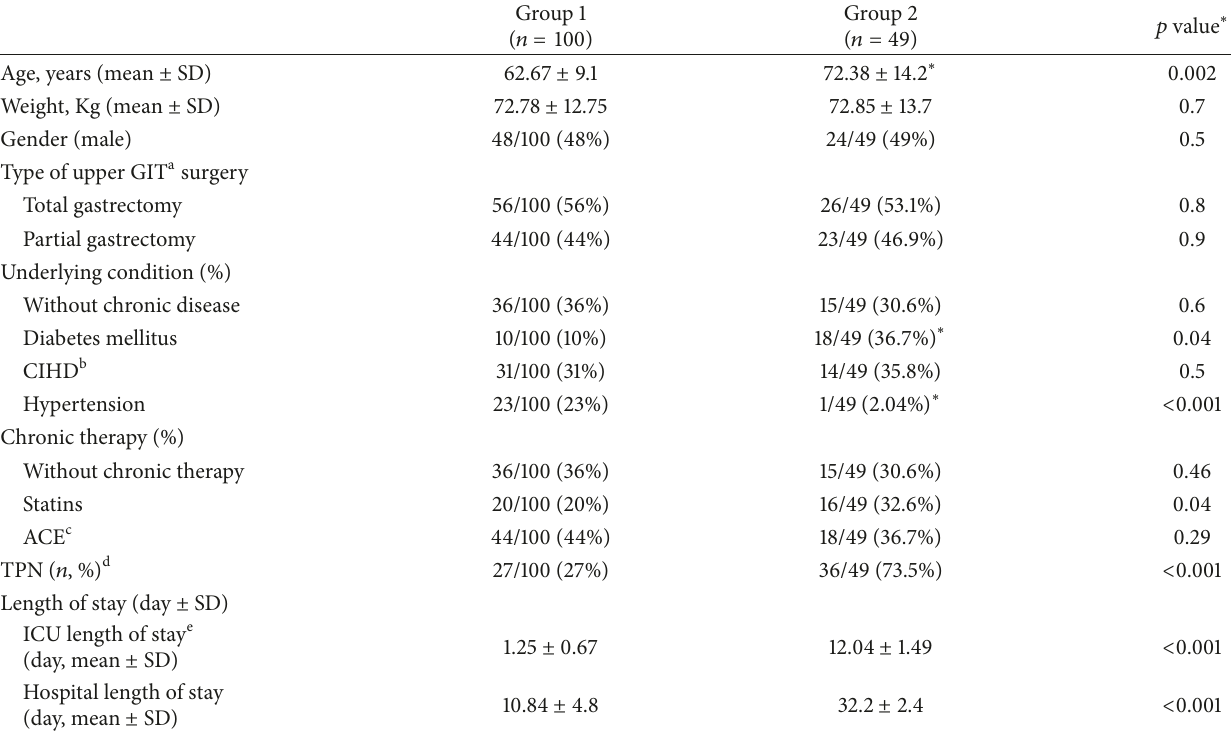
Table1:Patientdemographics,underlyingconditions,nutritionaldata,lengthofICU,andhospitalstay(Group1:noinfectiouscomplications; Group 2: patients who developed documented intra-abdominal